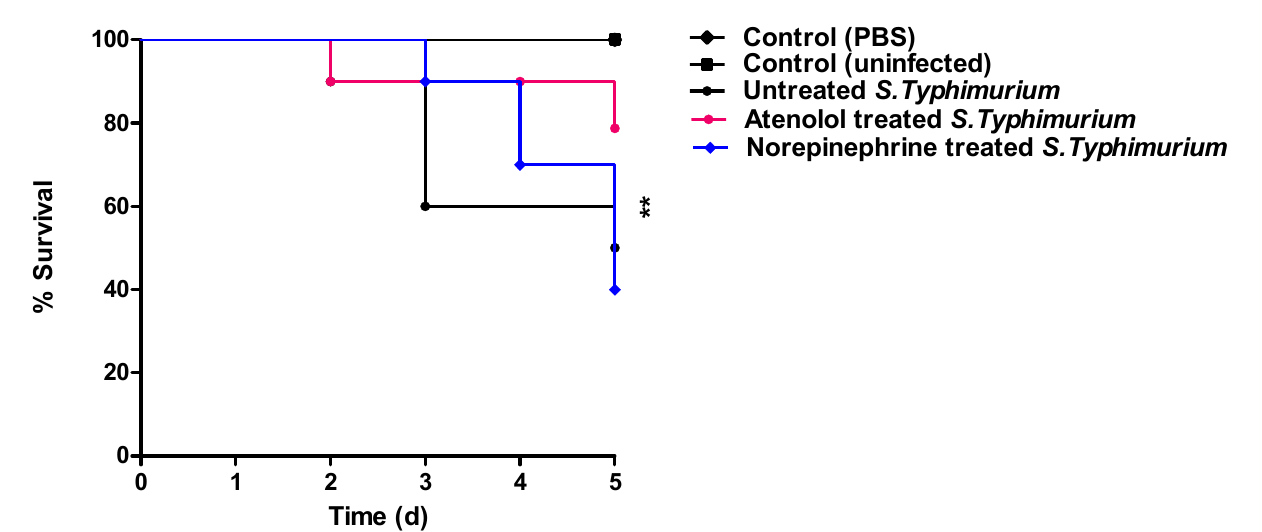
Figure 5. Atenolol diminished the S. typhimurium virulence. However, all the mice survived in the negative control groups, and only 50% of mice survived in the positive control mice group injected with untreated S. typhimurium . Furthermore, norepinephrine increased the S. typhimurium pathogenesis causing a death rate of 60%. On the other hand, atenolol protected mice and decreased death rate to 20%, which indicates the significant atenolol ability to reduce the S. typhimurium capacity to kill mice (log rank test p = 0.0034). Mice survival in each group was recorded every day over 5 days, plotted using the Kaplan–Meier method and significance ( p < 0.05) was calculated using the Log rank test. ** p < 0.01.